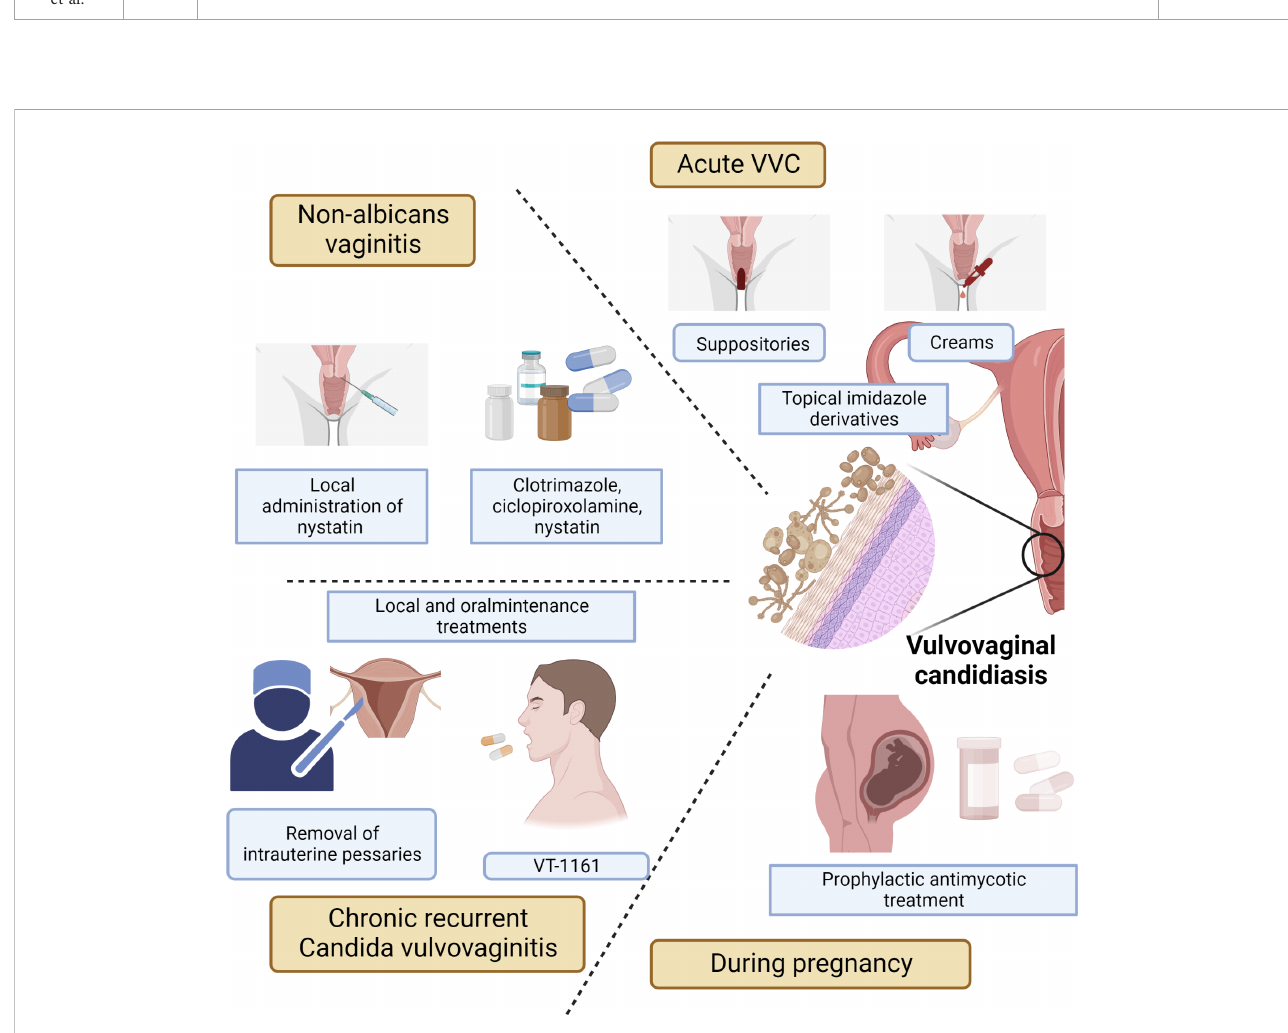
FIGURE 2 Treatments for acute VVC or recurrent VVC, including prescription oral formulations, over-the-counter topical preparations, and vaginal